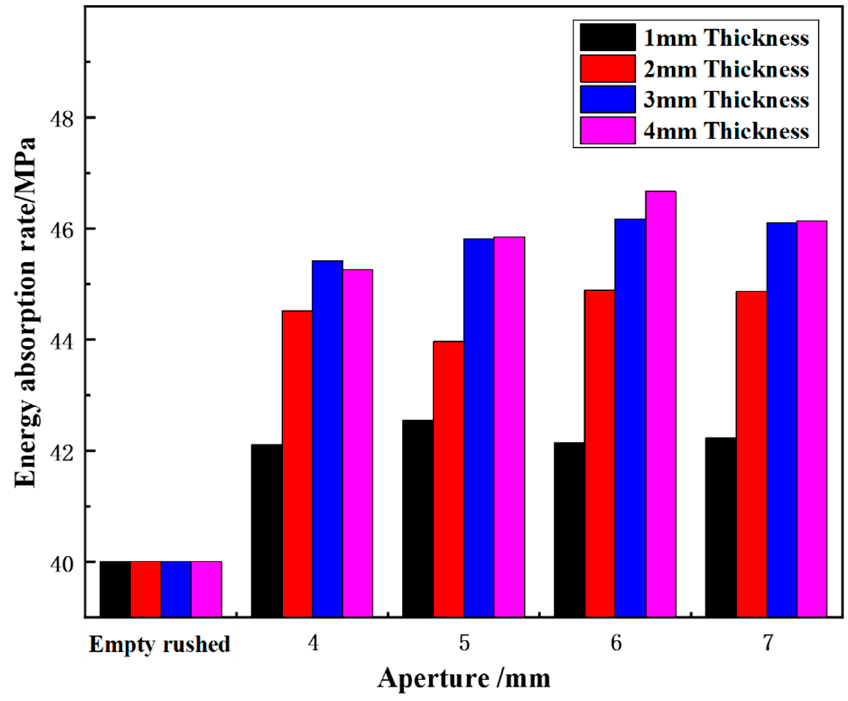
Figure 8. Variation trend of energy-absorption rate of wave-absorbing metal plate with aperture.